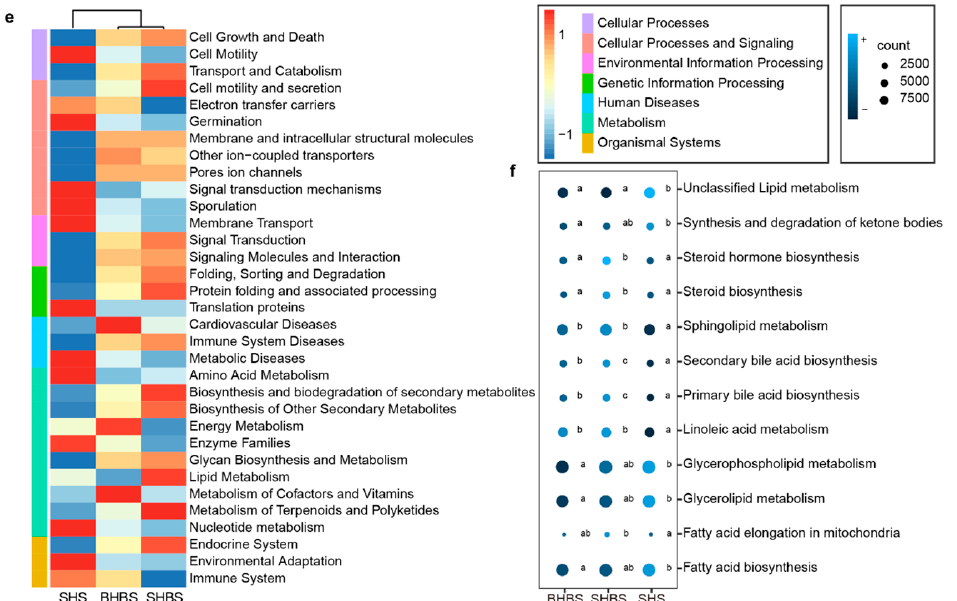
Figure 1. The different intestinal microbial communities between 3 sheep breeds. ( a ) Bacterial alpha diversity based on Shannon diversity, PD, and Chao1 index. * means the significant difference in statistics ( p < 0.05). Shannon diversity represented microbial community diversity, Chao1 represented species richness, and PD (phylogenetic diversity) generated from species richness and evolutionary distance. ( b ) The Bray Curtis dissimilarity of colon microbiota from the 3 breeds were used for PCoA plot. Each dot represented the composition of the microbiota of each sample. Samples were grouped by colors as label showed. ( c ) The Circos plot displayed the bacterial taxonomic composition at phylum level. The abundance of phylum Firmicutes in SHS group was much higher than that in the other two breeds ( p < 0.01), while the abundance of phylum Bacteroidetes in SHS group was much lower than that in the other two varieties ( p < 0.01). ( d ) The cladogram of intestinal bacterial communities showed evolutionary relationship between 3 levels of taxonomy (class, order, and family) with LDA scores over 2, which demonstrated a significantly different abundance between breeds. ( e , f ) Showed the KEGG pathways (enriched the statistical discrepancies of OTUs number). Heat map generated from hierarchical clustering analysis of the normalized OTUs in Level_1&2 KEGG pathway. The scatter plot indicated the Level_3 pathway of lipid metabolism, lowercase was used to show statistical differences between 3 breeds, and bubble size represented the number of OTUs, while the deepen color stood for the diminishing tendency of enriched OTUs number among 3 groups.